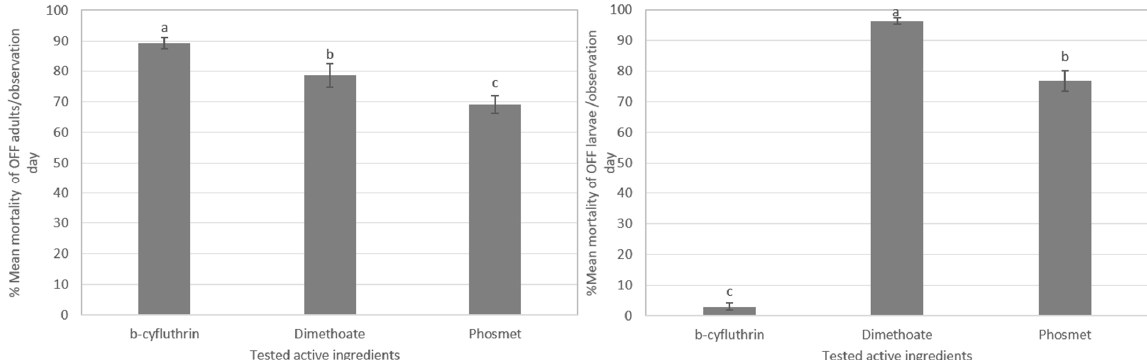
Figure 6. Mean ± SE recorded mortality of olive fruit fly adults ( left ) and larval stages ( right ) versus time. Records of mortality with the same letter are not significantly different at p < 0.05.